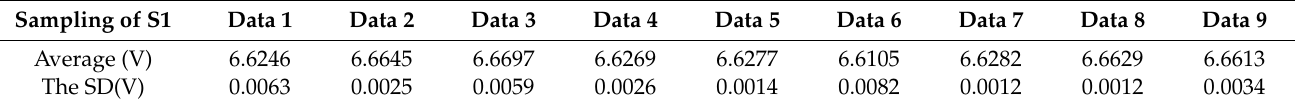
Table 2. Statistics table for S 1